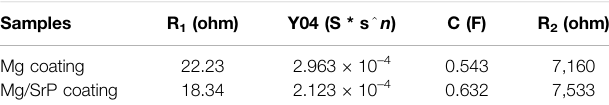
TABLE 3 | Fitting results of Mg and Mg/SrP coatings immersed in D-Hank ’ s solution.